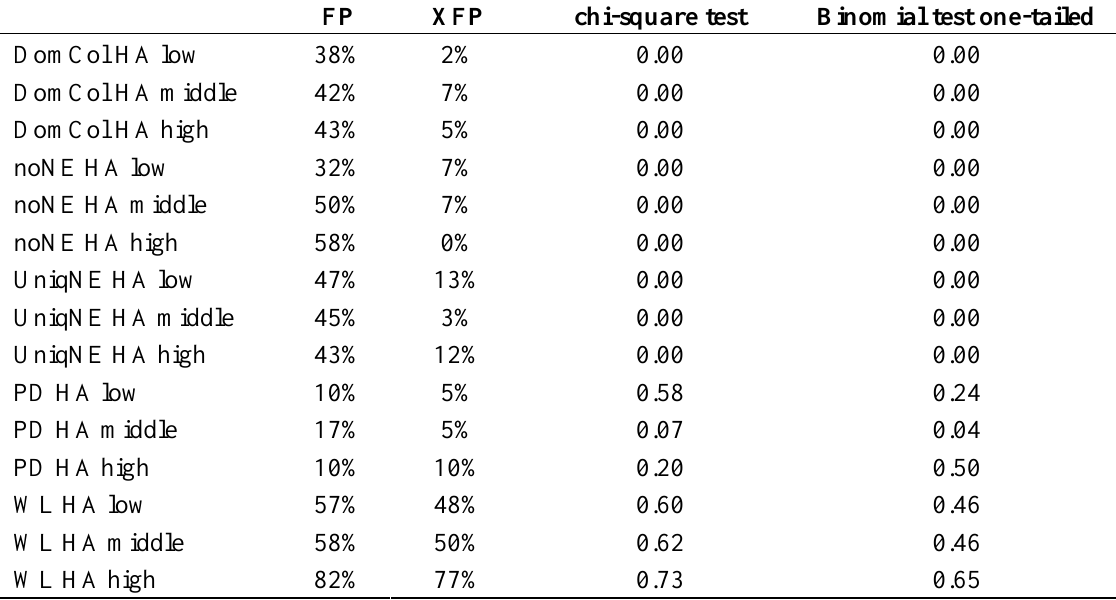
Table 3. Frequencies of FP and XFP choices for row players, and corresponding p -values. FP XFP chi-square test Binomial test